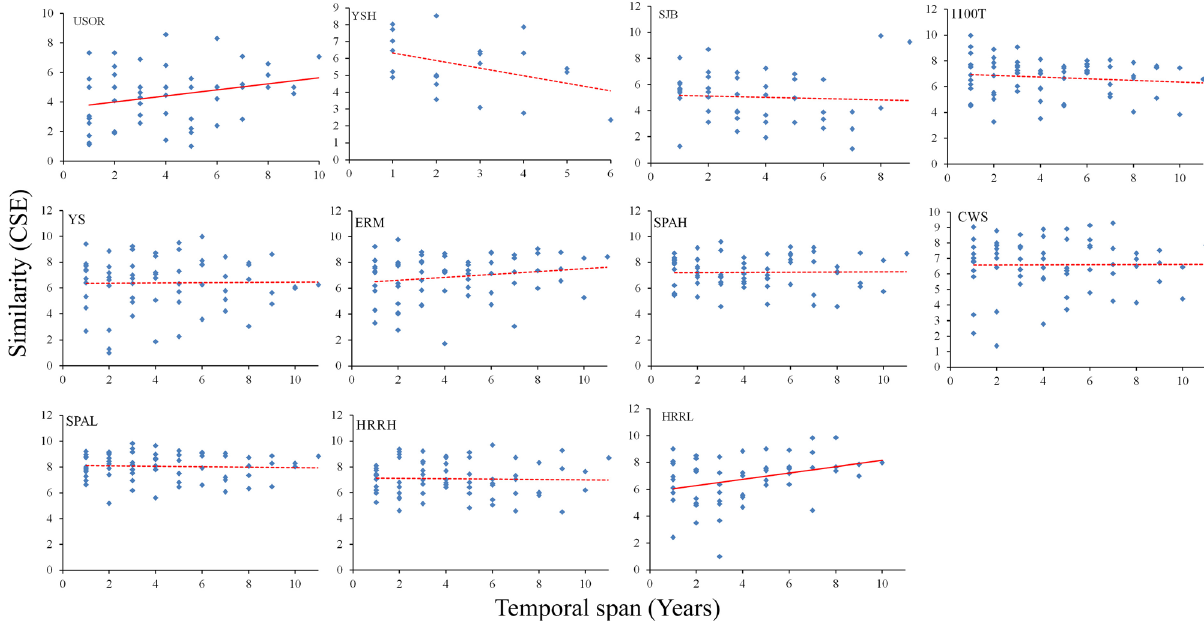
Figure 3. The similarity of moth assemblages at 11 sites against the temporal span from 2009 to 2020 in HNP. The similarity index was calculated by Chao-Sørensen estimated abundance-based (CSE) index. The solid line indicates the significant relationship between the similarity and time span at P <